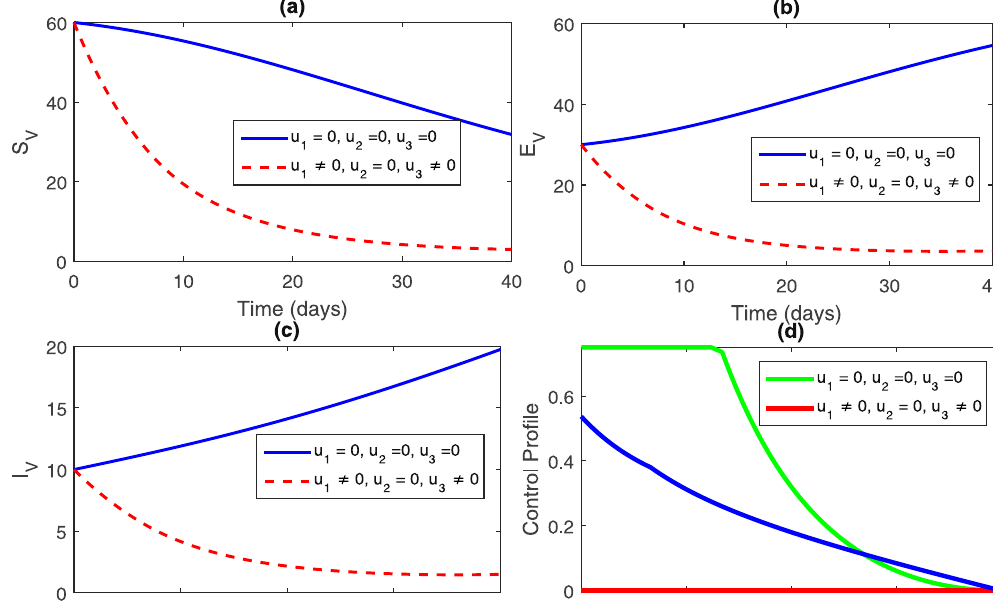
Figure 5. Comparison of both the systems: without and with control.